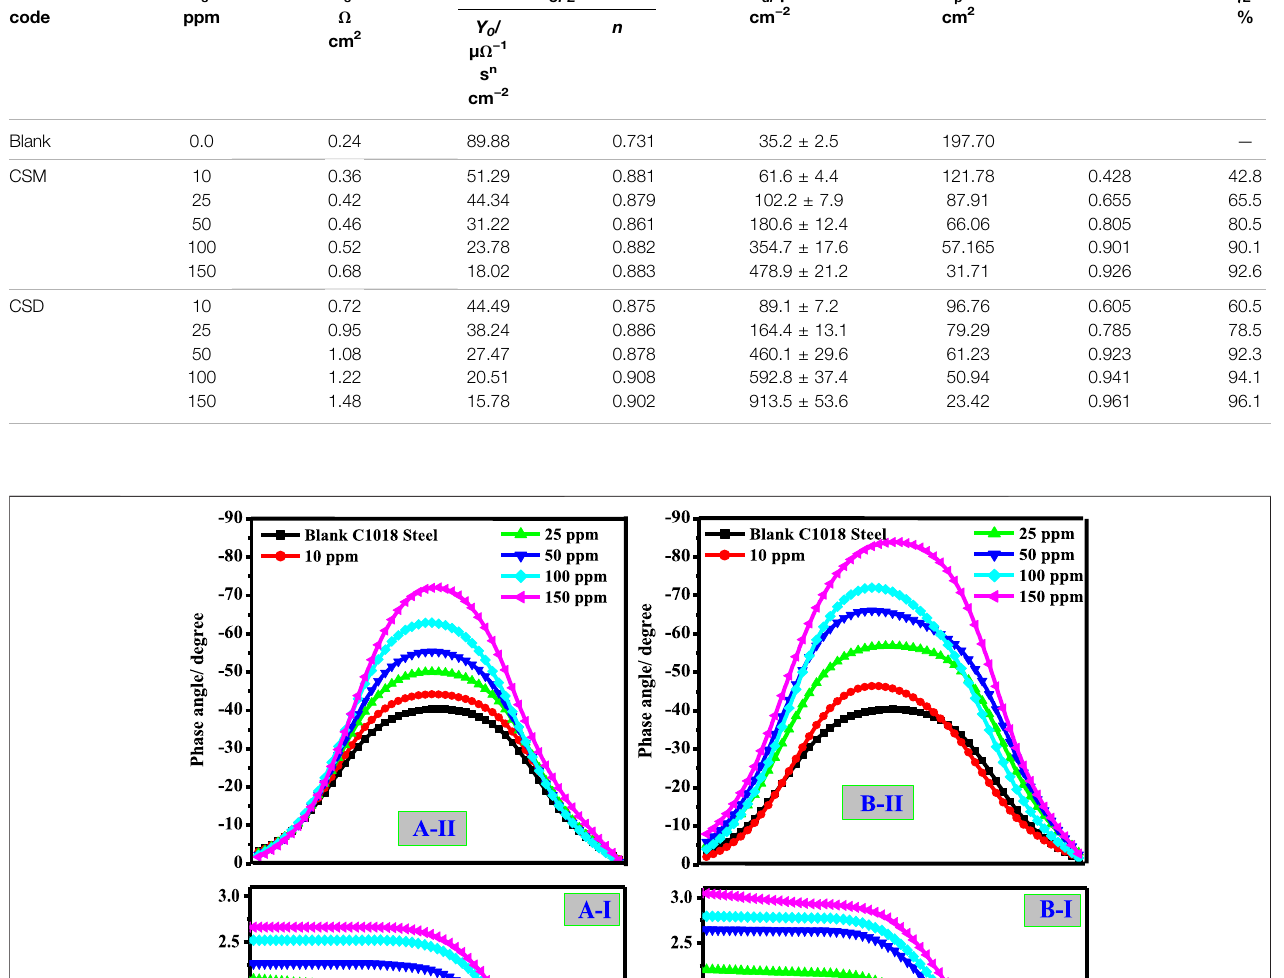
Frontiers in Materials |